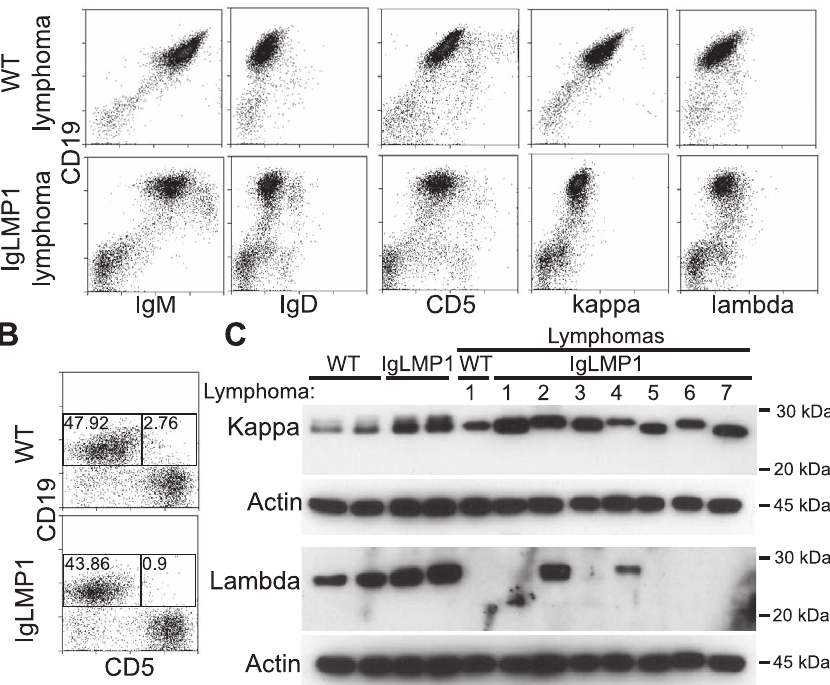
Figure 2. LMP1 Promotes B-1a Lymphomas That Can Escape Allelic Exclusion (A) Flow cytometry analysis of splenocytes from a WT or LMP1 transgenic lymphoma for the pan–B cell (CD19), B-1a cell (CD5), and Ig heavy chain (IgM and IgD) and light chain ( j and k ) markers. Shown are the results from WT lymphoma 1 and LMP1 transgenic lymphoma 4. This analysis was repeated on four other LMP1 transgenic lymphomas (1, 2, 3, and 6) showing a similar B-1a phenotype, of which lymphomas 2 and 4 were also doubly positive for j and k light chains. (B) Flow cytometry analysis of WT or LMP1 transgenic splenocytes for B-1a (CD19 þ CD5 þ ) and B-1b or B2 subsets (CD19 þ CD5 (cid:2) ). Percentages of B-1a and B-1b or B2 subsets are shown in each quadrant. This analysis was repeated on three other WT and two other LMP1 transgenic mice with similar results. (C) Immunoblot analysis for j and k light chains of B cells (CD19 þ ) purified from WT and LMP1 transgenic mice. Actin was used as a loading control.